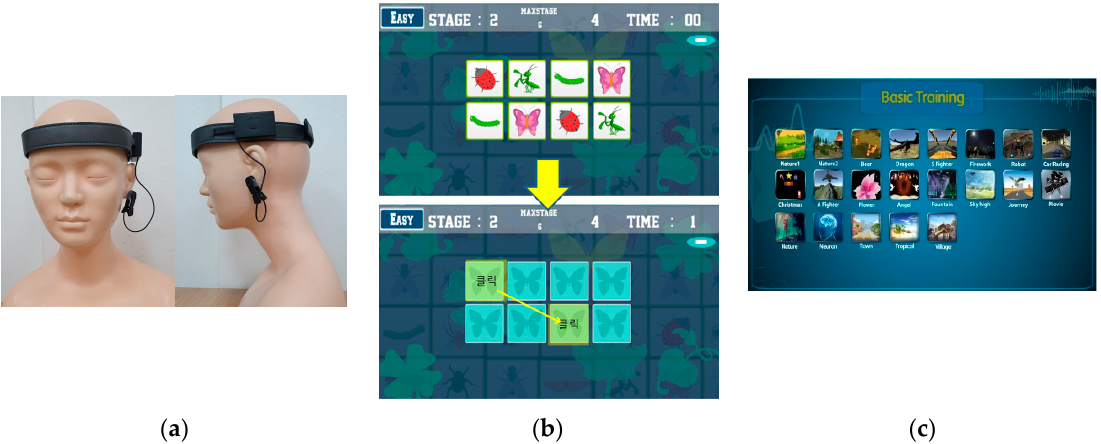
Figure 3. Example of the cognicise-neurofeedback screen. ( a ) wearing device of neurofeedback; ( b ) memorizing and matching the same images; ( c ) categories of basic training screen.